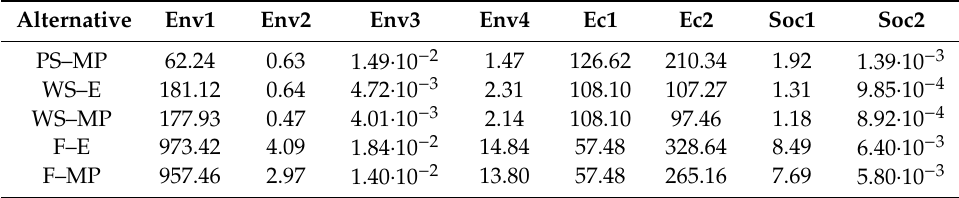
Indicator results applied in the MCDA for prioritisation of wood-based residential heating